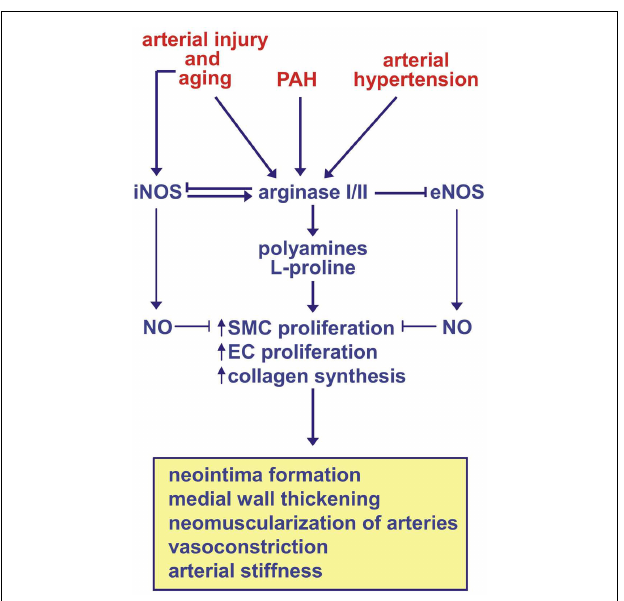
FIGURE 2 | Model for the regulation of vascular remodeling by arginase in arterial injury, pulmonary arterial hypertension (PAH), arterial hypertension, and aging . Arterial injury, PAH, arterial hypertension, and aging stimulates the activity and/or expression of arginase I or II in blood vessels, while arterial injury and aging also stimulates the expression of inducible nitric oxide (NO) synthase (iNOS).The induction of iNOS by aging or arterial injury may further augment the activation of arginase I by nitrosylating a specific cysteine residue of the enzyme. Activation or induction of both arginase isoforms stimulate vascular smooth muscle cell (SMC) and endothelial cell (EC) proliferation, and collagen synthesis by increasing the production of polyamines and L-proline.These cellular actions of arginase are further amplified by the ability of arginase to limit the metabolism of L-arginine by iNOS and endothelial NO synthase (eNOS) to NO, which is a known inhibitor of SMC proliferation and collagen synthesis. Collectively, these arginase-driven events result in neointima formation, medial wall thickening, neovascularization of small arteries, vasoconstriction, and/or arterial